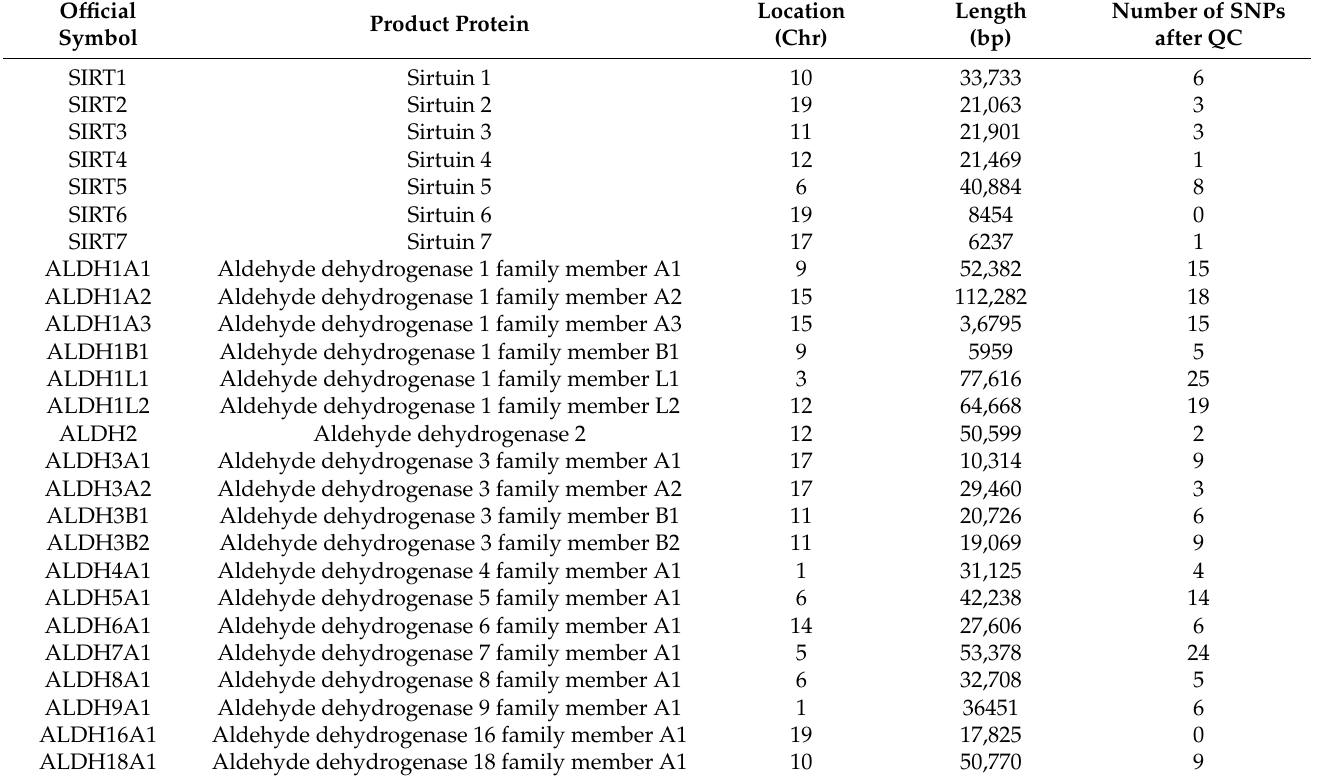
Table 2. SNPs information and the results for SIRTs & ALDHs.